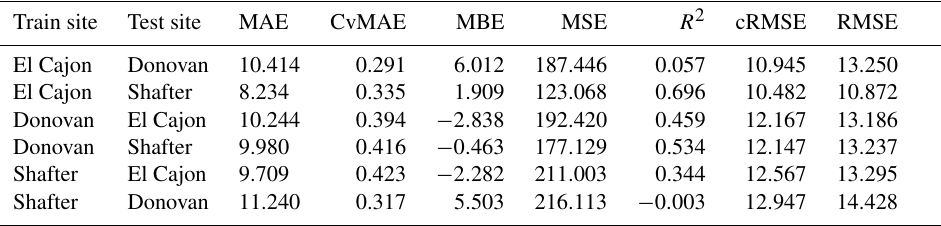
Table D4. Test results for split-NN Level 1, size 9 (O 3 ).